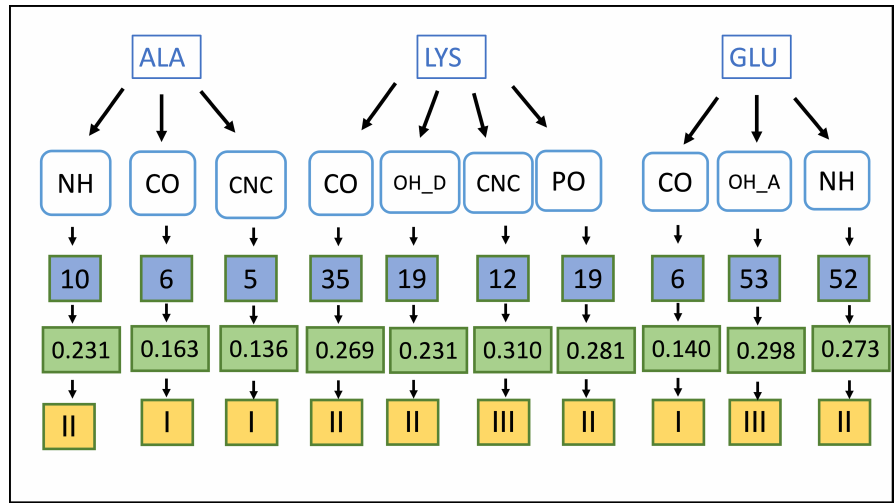
Figure 15. Sample analysis for investigating potential functional groups for a binding pocket with ALA, LYS, and GLU. Blue, Green, and yellow filled shapes represent natural occurrences, average local mode force constants (in mDyn/Å) and HB strength category, respectively. Ligand functional groups are NH: N–H, CO: C=O, OH_A: O–H acceptor, OH_D: O–H donor, CNC: C–N–C, and PO: P=O. HB strength category changes according to: I < II <